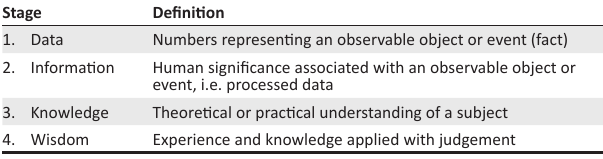
TABLE 1: Hierarchical presentation and some